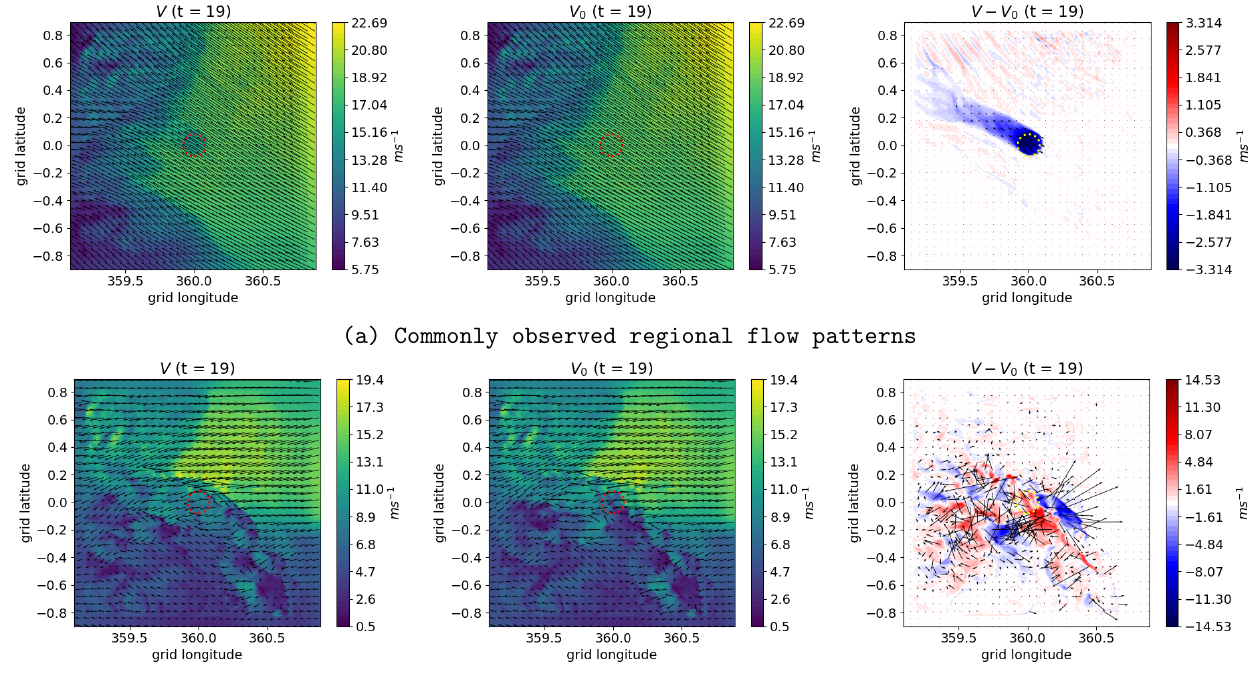
Figure 7. Histograms of ζ obtained from 10 different sets of “two-day hourly average” twin simu- lations: ( a ) With all 240 data points ( b ) with 230 data points where 0.8 < β < 0.9 ( c ) with 213 data points where U F > 5 m/s.